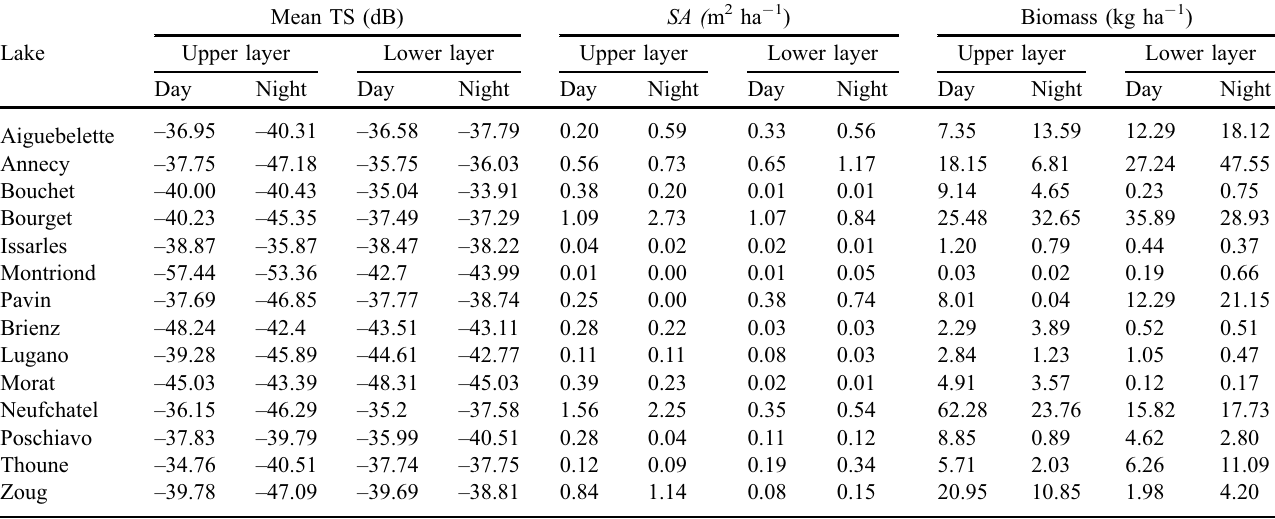
Table 2. Hydroacoustic survey results. Estimated mean SA , mean TS, and biomass from day-time and night-time surveys by lake and depth layer. Mean TS